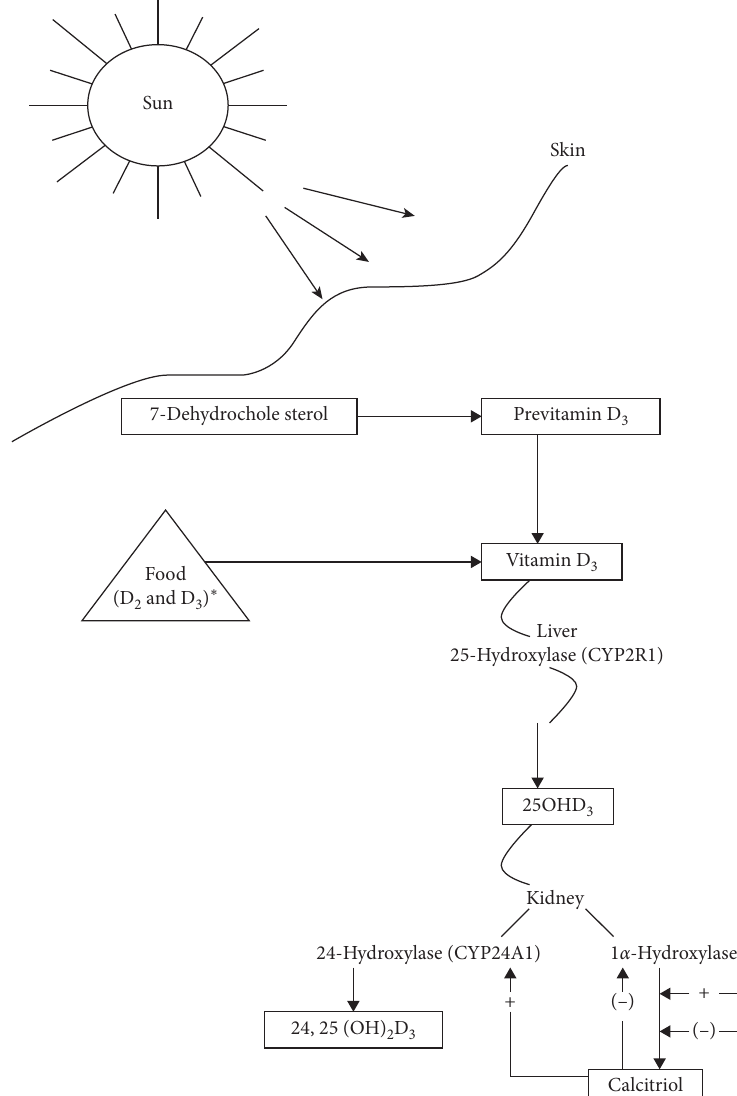
Figure 3: Pathway of vitamin D synthesis and metabolism (adapted from dietary reference intakes for calcium and vitamin D